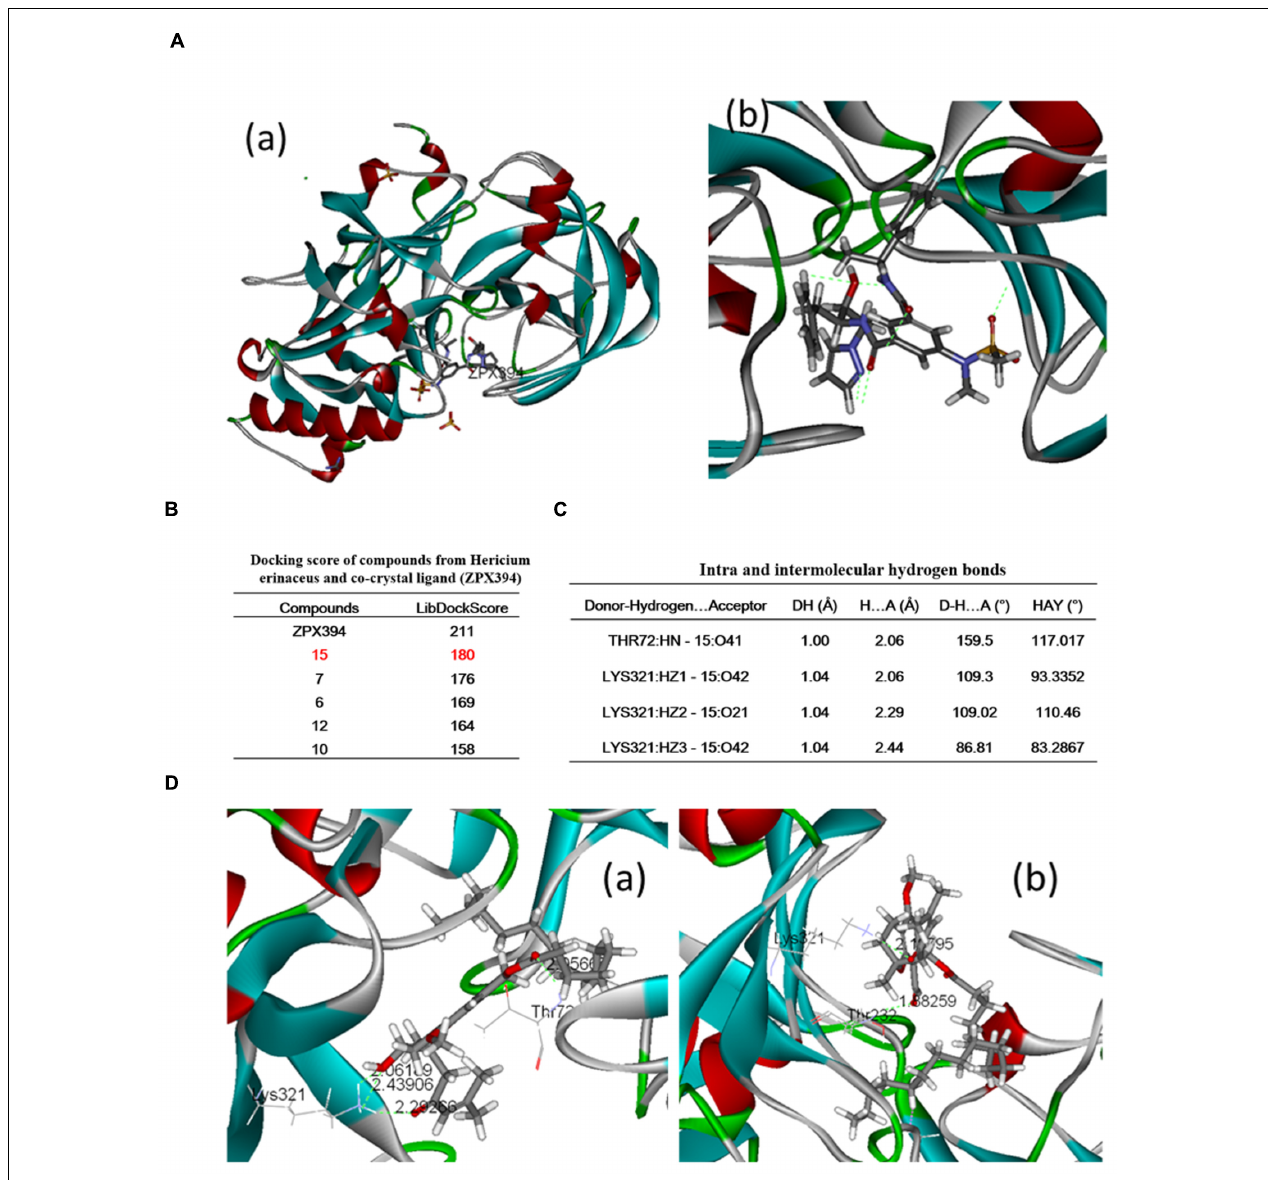
FIGURE 3 | Binding pattern of H. erinaceus compounds: (A-a) crystal structure of BACE1; (A-b) binding modes and co-crystal ligand in BACE1; (B) docking scores of compounds from H. erinaceus and co-crystal ligand (ZPX394); (C) intra and intermolecular hydrogen bonds; (D-a) crystal structure of BACE1 and (D-b) 3-Hydroxyhericenone F-mediated hydrogen bond interactions with Lys321 and Thr72 (green